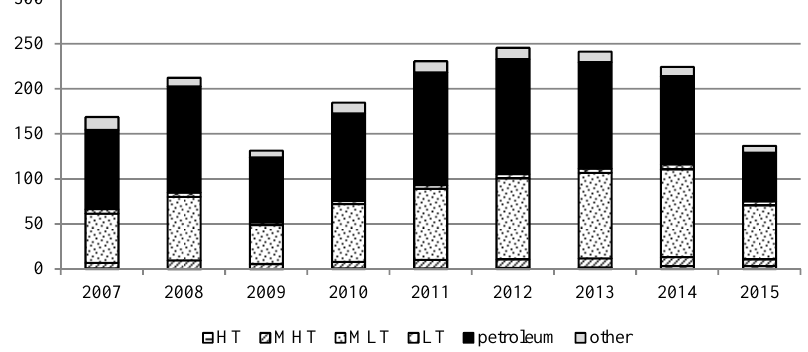
Figure 1. Goods structure of Russian exports to the EU28 in 2007–2015 (billion